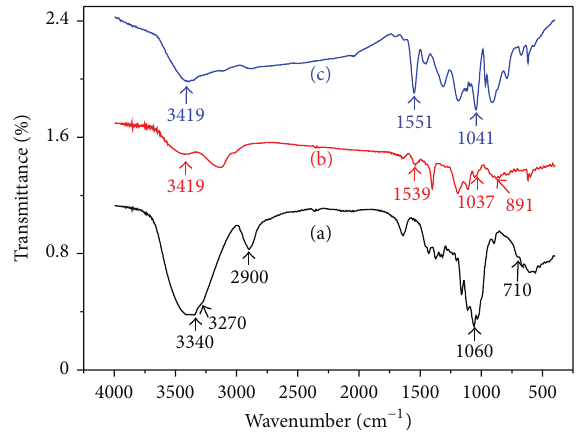
Figure 2: FT-IR spectra of TC (a), PPy (b) and the film of PPy/T- CNs nanocomposite